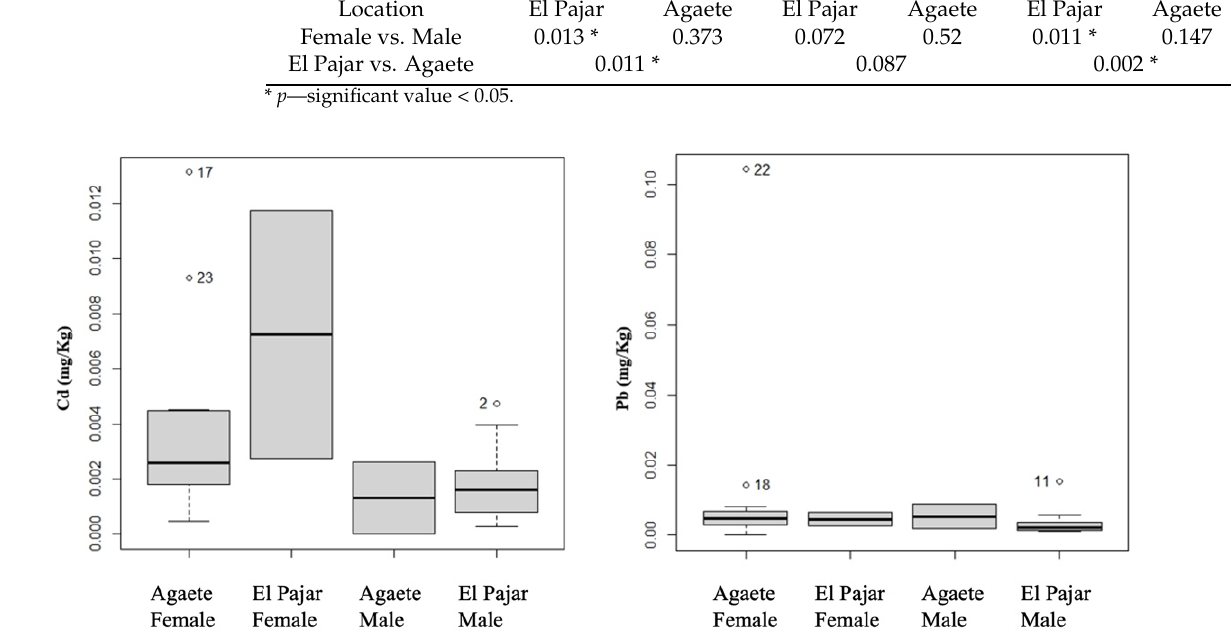
Figure 3. Box plot for Cd and Pb (mg/kg) in muscle tissue with the location and sex factors.